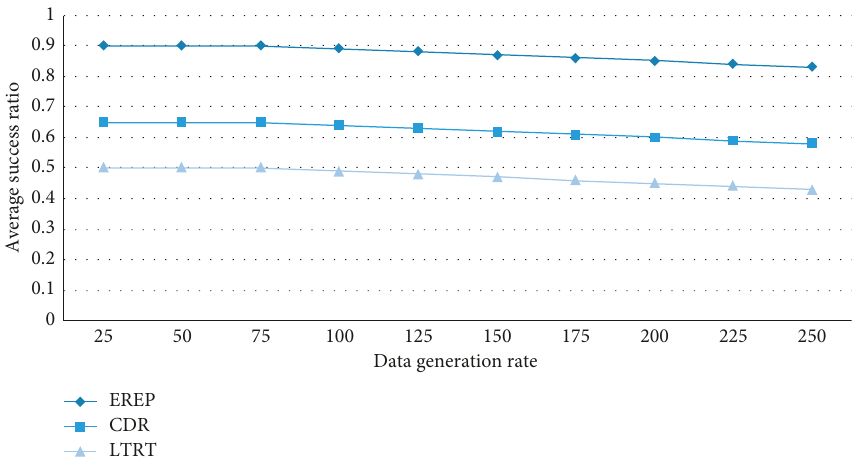
Figure 5: Data generation rate vs. packet success ratio at different link